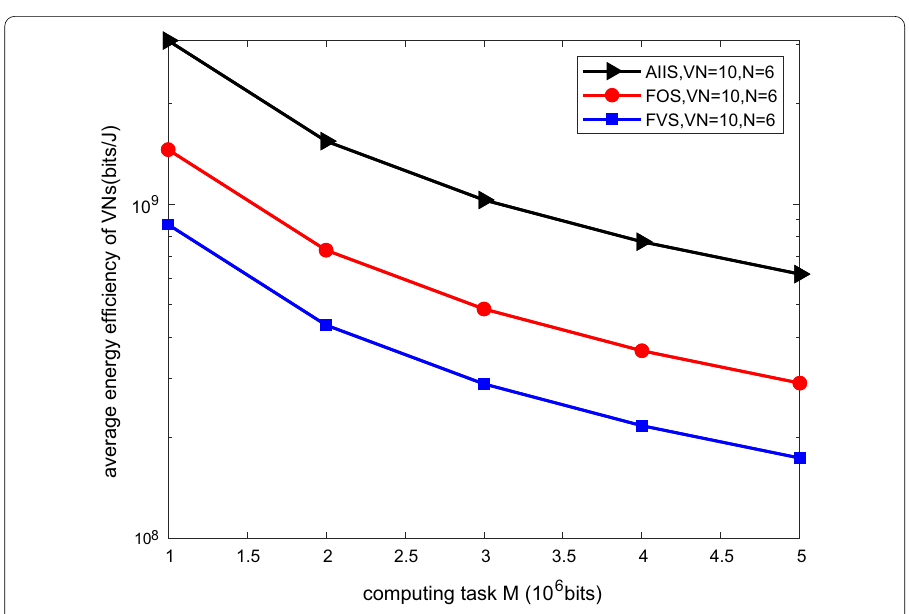
Fig. 3 The average energy efficiency of vehicles versus the computation task